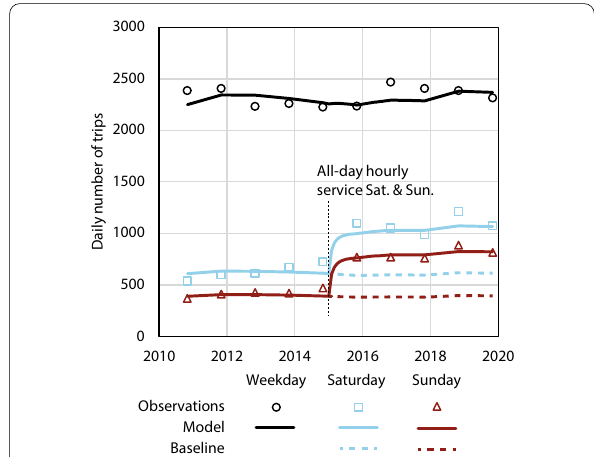
Fig. 6 Patronage development in case C, coach and bus services from Kristianstad to Simrishamn and Ystad (SkåneExpressen 3 and 4 together with route 337 and 573), showing annual autumn measurements and model estimations of the patronage development with and without off‑peak service improvements (the latter corresponds to the counterfactual baseline